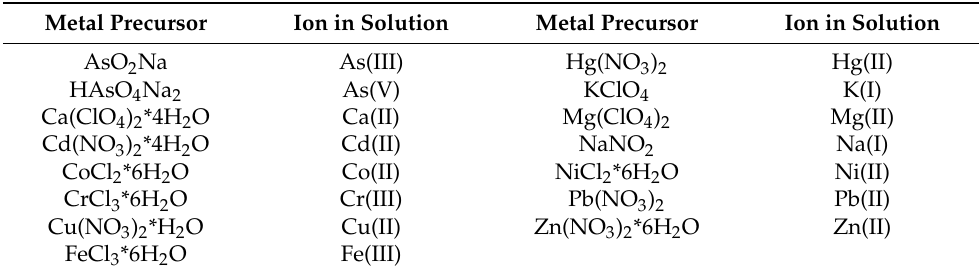
Table 1. Metal ions tested in the selectivity and interference